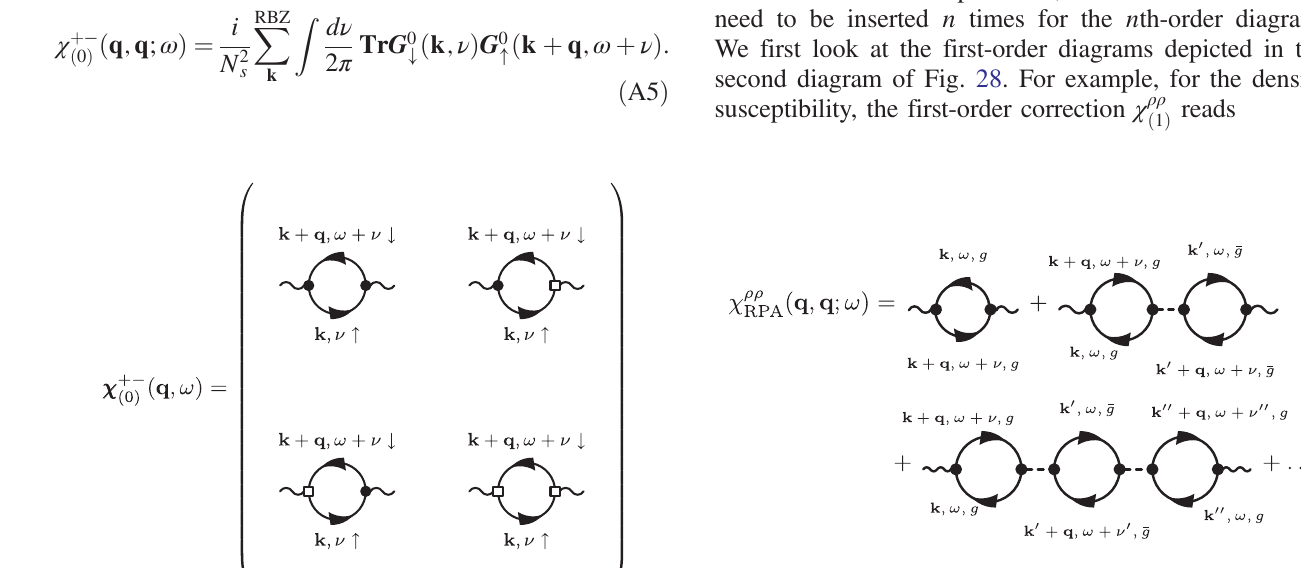
FIG. 28. Diagrammatic representation of the RPA series for the density susceptibility. The first-order term is the MFT bubble. The sums over internal momenta k , k 0 , k 00 , and frequencies ν , ν 0 , ν 00 have not been written explicitly. ¯ g stands for the opposite spin of g